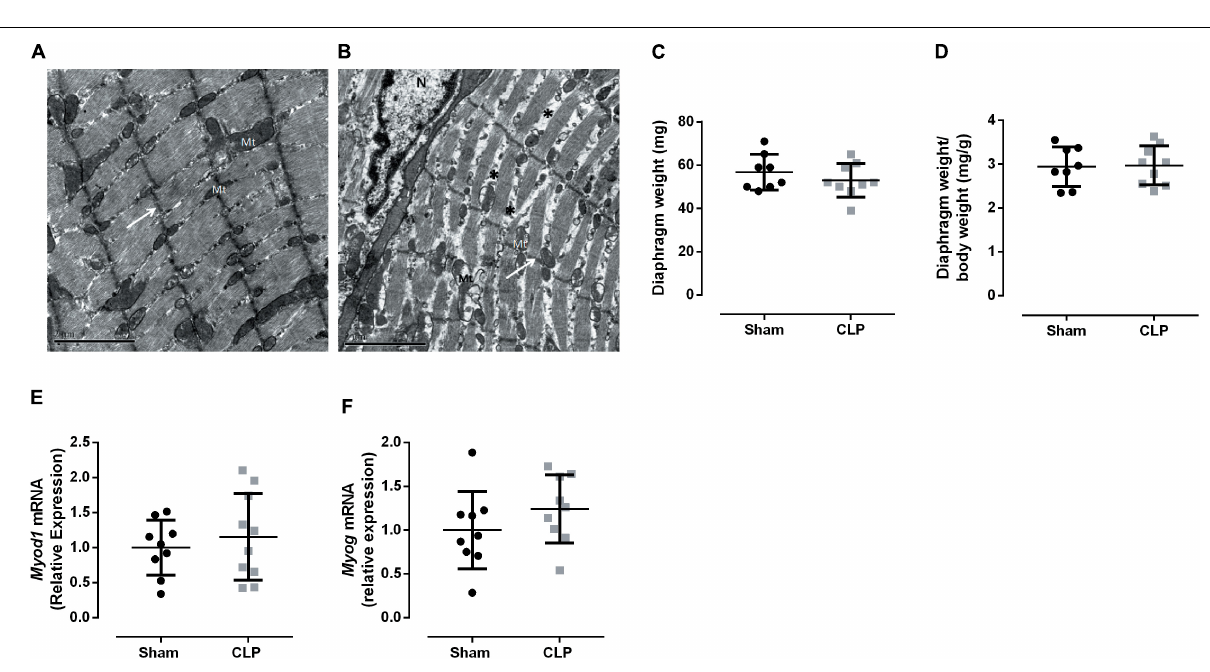
FIGURE 2 | Prolonged sepsis disturbs diaphragm morphology. Transmission electron micrograph of Sham (A) and CLP (B) diaphragm fragments, white arrows indicate Z lines, * exemplify low electrodense areas between sarcomeres, N indicates the nucleus and Mt mitochondria, scales bars represent 2 µ m. Diaphragm total weight (C) and related to animal body weight (D) . Expression of Myod1 (expressed by activated satellite cells and myoblast; E ), Myog (expressed by myocytes and early myotubes F ). Black dots represent sham animals caused by surgical stress, and gray squares represent CLP – cecal ligation puncture technique. Values are expressed as mean ± SD, * p < 0.05, and ** p < 0.005 compared with the sham